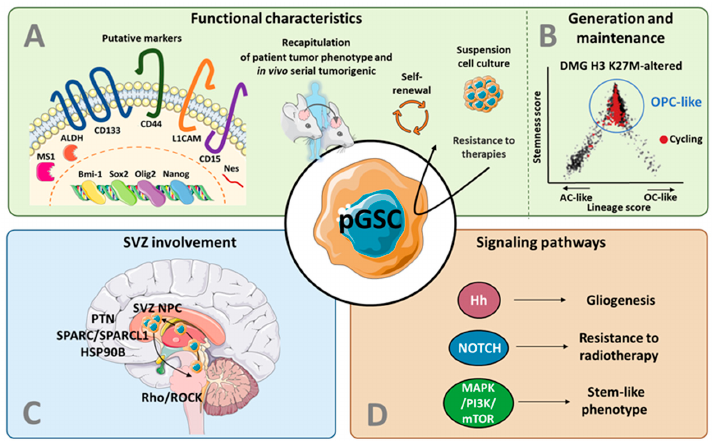
Figure 2. Graphical summary illustrating the functional evidences of GSCs existence in pHGG ( A ), their generation and maintenance in pHGG ( B ), the role of the SVZ ( C ), and the signaling pathways involved in GSC-features ( D ). While there is no clear consensus, glioma stem cells (GSC) are classi- cally defined based on multiple functional criteria, including the expression of different levels and patterns of surface and intracellular markers, the formation of spherical colonies in suspension cul- tures, a higher resistance to radiation and/or chemotherapy compared to the non-GSCs tumoral cells and the potential to recapitulate the initial tumor heterogeneity ( A ). scRNA-seq analysis of primary Diffuse Midline Glioma (DMG) H3 K27-altered showed that tumor cells are mostly constituted of cells that resemble oligodendrocyte precursor cells, which display an enhanced proliferative and tumor-propagating capacity compared to the minority of more differentiated cells (astrocyte-like and oligodendrocyte-like) ( B ). The subventricular zone (SVZ) is a key actor in pediatric high-grade gliomas (pHGG), as suggested by the recent in vivo demonstration that DMG cells injected in the pons migrate towards the SVZ in response to chemoattractant signals secreted by SVZ-hosted neu- ral precursor cell. This chemoattractant effect depends on the pleiotrophin (PTN) and its three bind- ing partners and is mediated by the PTN receptor protein tyrosine phosphate receptor type Z and the activation of the Rho/Rho kinase pathway ( C ). Several signaling pathways are shared between neural stem cells and pediatric GSC and are involved in gliogenesis, resistance to radiotherapy, and stem-like phenotype of pHGG ( D ). Abbreviations: AC: astrocyte; ALDH: aldehyde dehydrogenase; Bmi-1: B cell-specific moloney murine leukemia virus integration site 1; DMG: diffuse midline gli- oma; Hh: hedgehog; HSP90B: heat shock protein 90B; L1CAM: L1 cell adhesion molecule; MAPK: mitogen-activated protein kinase; MSI1: mushashi-1; mTOR: mammalian target of rapamycin; Nes: nestin; NPC: neural precursor cell; OC: oligodendrocyte; Olig2: oligodendrocyte transcription factor 2; OPC: oligodendrocyte progenitor cell; pGSC: pediatric glioma stem cell; PI3K: phosphatidylino- sitol 3 ′ –kinase; PTN: pleiotrophin; ROCK: Rho-associated protein kinase; Sox2: SRY-Box transcrip- tion factor 2; SPARC: secreted protein acidic and rich in cysteine; SPARCL1: SPARC-like protein 1; SVZ: subventricular zone. The schematic art pieces used in this figure were provided by Servier Medical art (https://smart.servier.com), 25 April 2022. Servier Medical Art by Servier is licensed un- der a Creative Commons Attribution 3.0 Unported License. Figure 2B is adapted from Filbin et al. [56]. 3.1. Putative Markers for GSCs in pHGG As described above, adult GSCs have been defined based on their capacity to self- renew, differentiate, and form tumors. Several proteins and transcription factors were proposed as putative markers, although it is nowadays well-accepted that their expres- sion lacks specificity and consistency, and does not allow the accurate isolation of GSCs from other tumor cells [57]. Nonetheless, the many studies that harnessed such markers to support the existence of GSCs in pediatric HGG definitely contributed to the current